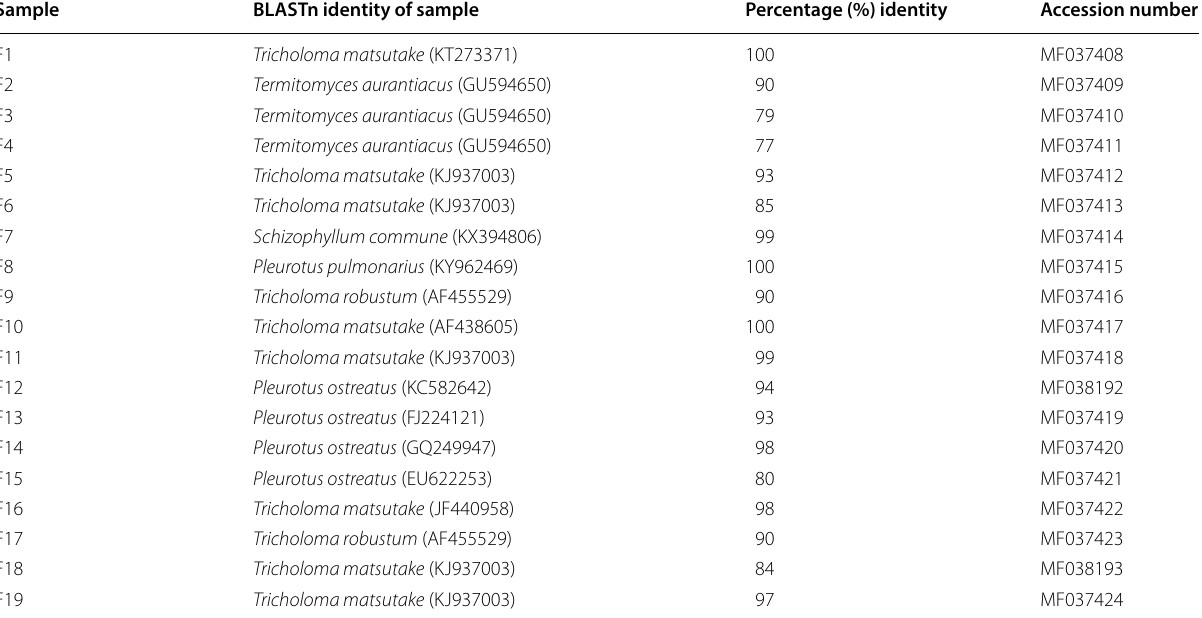
Table 2 Summary of BLASTn results Sample BLASTn identity of